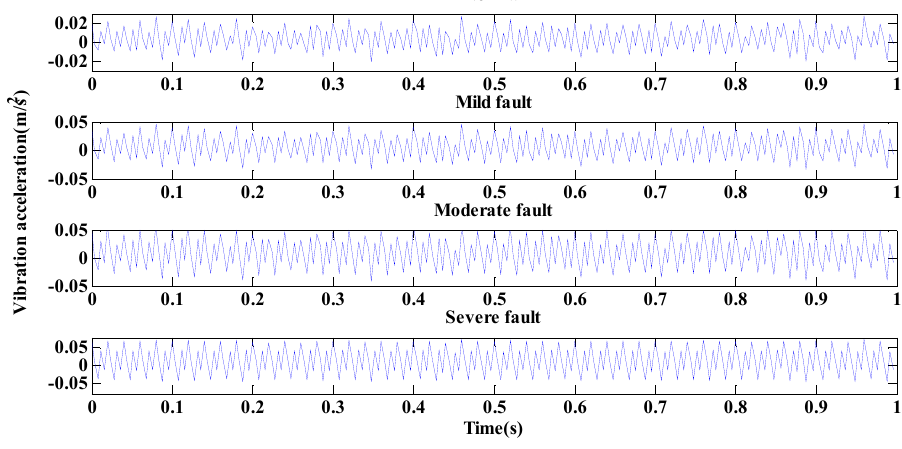
Figure 1. Transformer vibration signals of four types of fault.